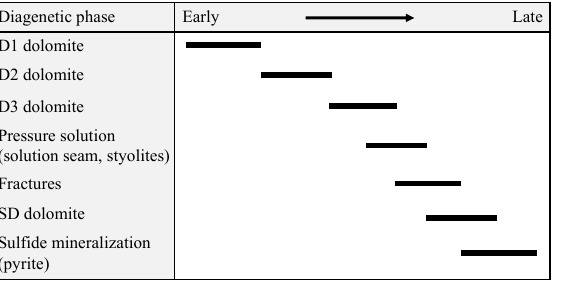
Figure 8. Diagenetic sequence of the Xixiangchi Formation in Eastern Sichuan Basin.